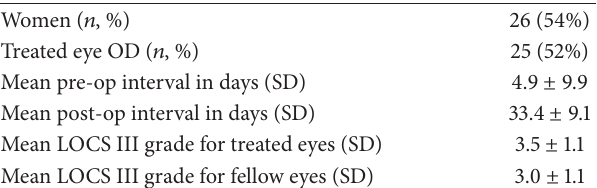
Table 2: Demographics of the study